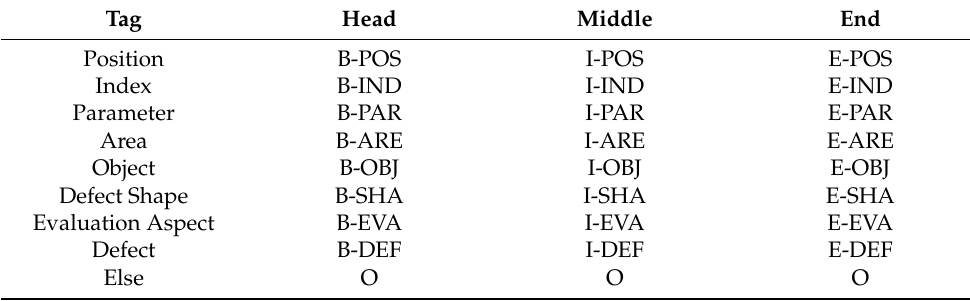
Table 1. Marking form of hot strip rolling.